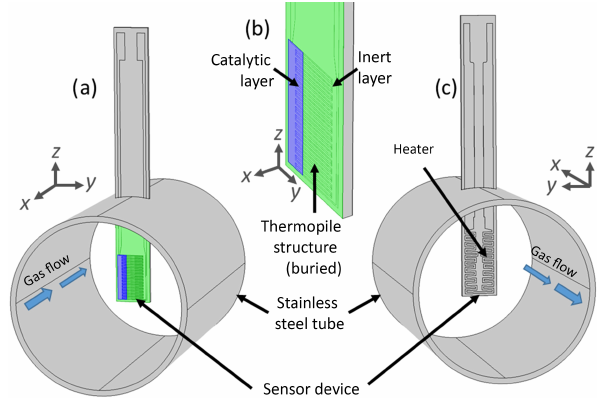
Figure 2. Geometry as implemented in COMSOL Multiphysics ® . (a) View of the front of the setup used for measurements. (b) Closer view of the front of the sensor surface with thermopile structure buried under the inert (green domain) and catalytically activated layer (blue domain). (c) View of the reverse side of the sensor sur- face with heating element. The blue arrows depict the gas flow di-